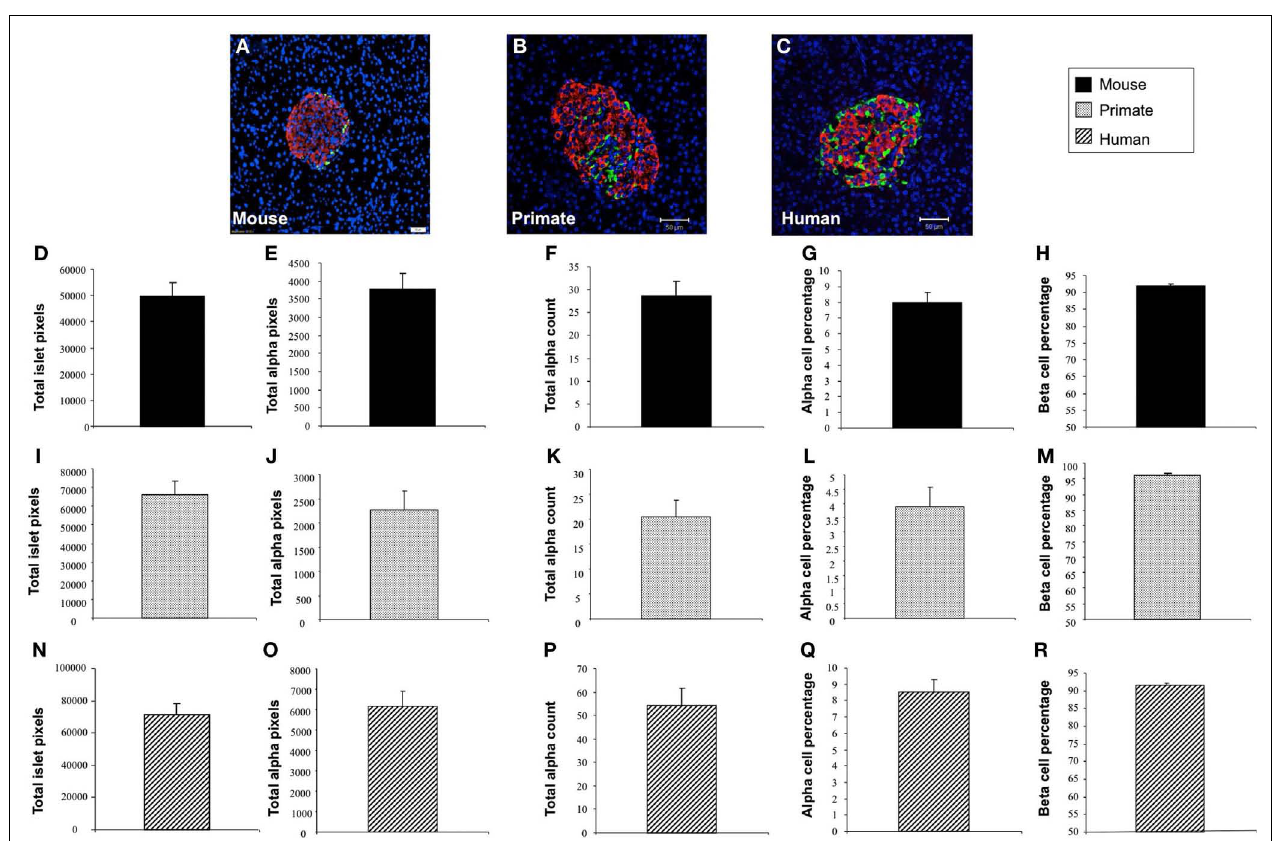
area of primate pancreatic islet images (arbitrary units); (K) total alpha-cell numbers of primate pancreatic islet images; (L) alpha-cell percentage of primate pancreatic islet images; (M) beta-cell percentage of mouse pancreatic islet images; (N) total islet area of human pancreatic islet images (arbitrary units); (O) total alpha-cell area of human pancreatic islet images (arbitrary units); (P) total alpha-cell numbers of human pancreatic islet images; (Q) alpha-cell percentage of human pancreatic islet images; (R) beta-cell percentage of human pancreatic islet images. Data are means ± SEM.